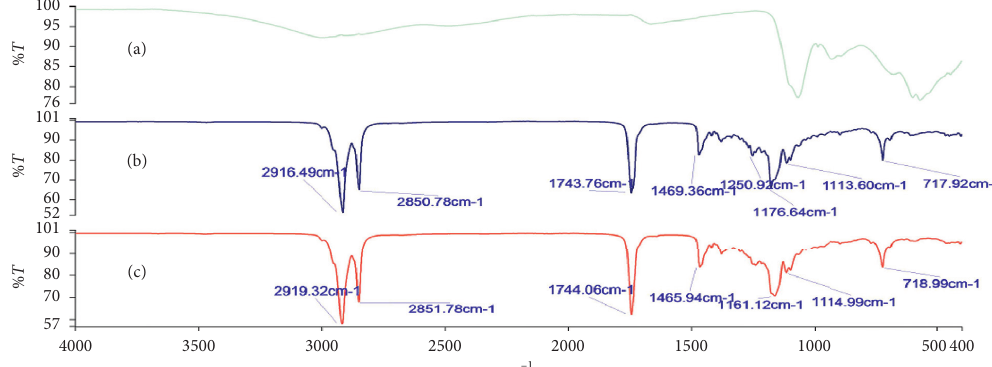
Figure 5: FT-IR spectra of (a) alum, (b) shea butter+theobroma oil+alum (1:1 :1), and (c) shea butter+theobroma oil (1 :1).